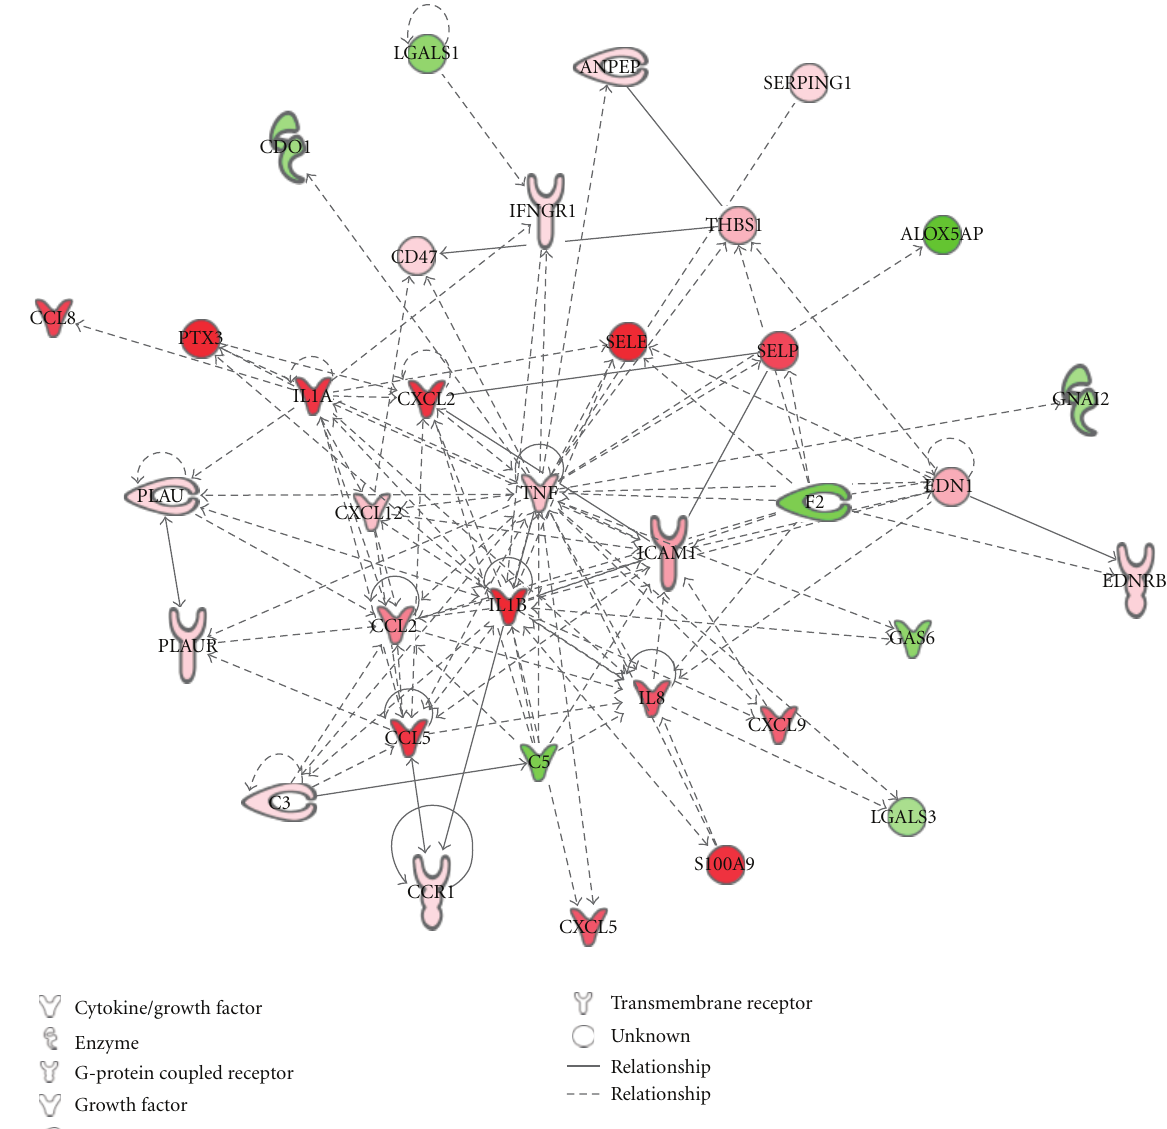
Figure 5: Inflammatory gene network associated with upregulation of TNF α . In the network, green represents genes with reduced expression while pink and red nodes denote a significant increase in gene